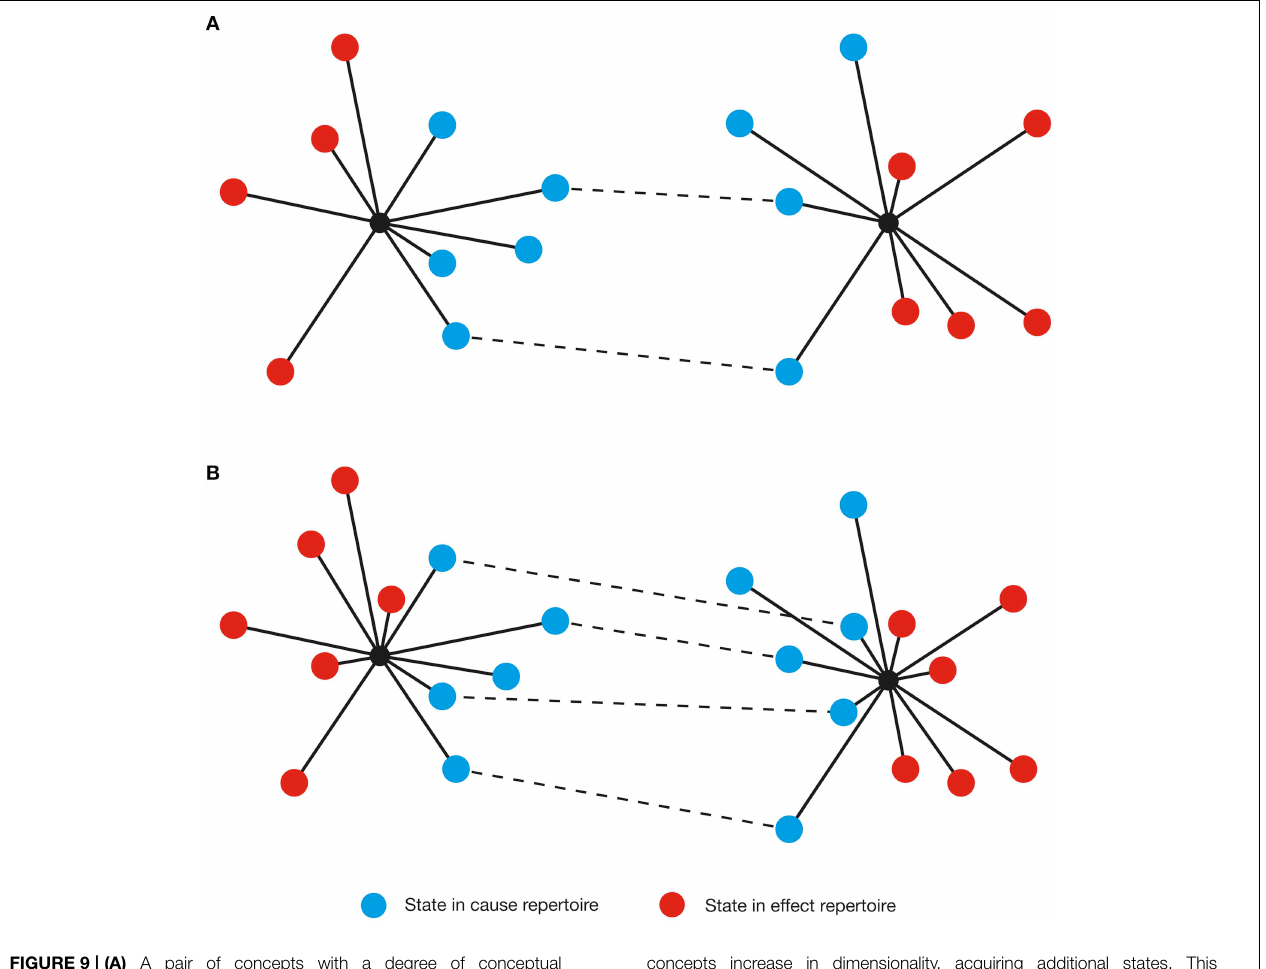
FIGURE 9 | (A) A pair of concepts with a degree of conceptual overlap (shared states [in cause repertoire only for clarity] are indicated by dashed lines). (B) In the psychedelic state, the